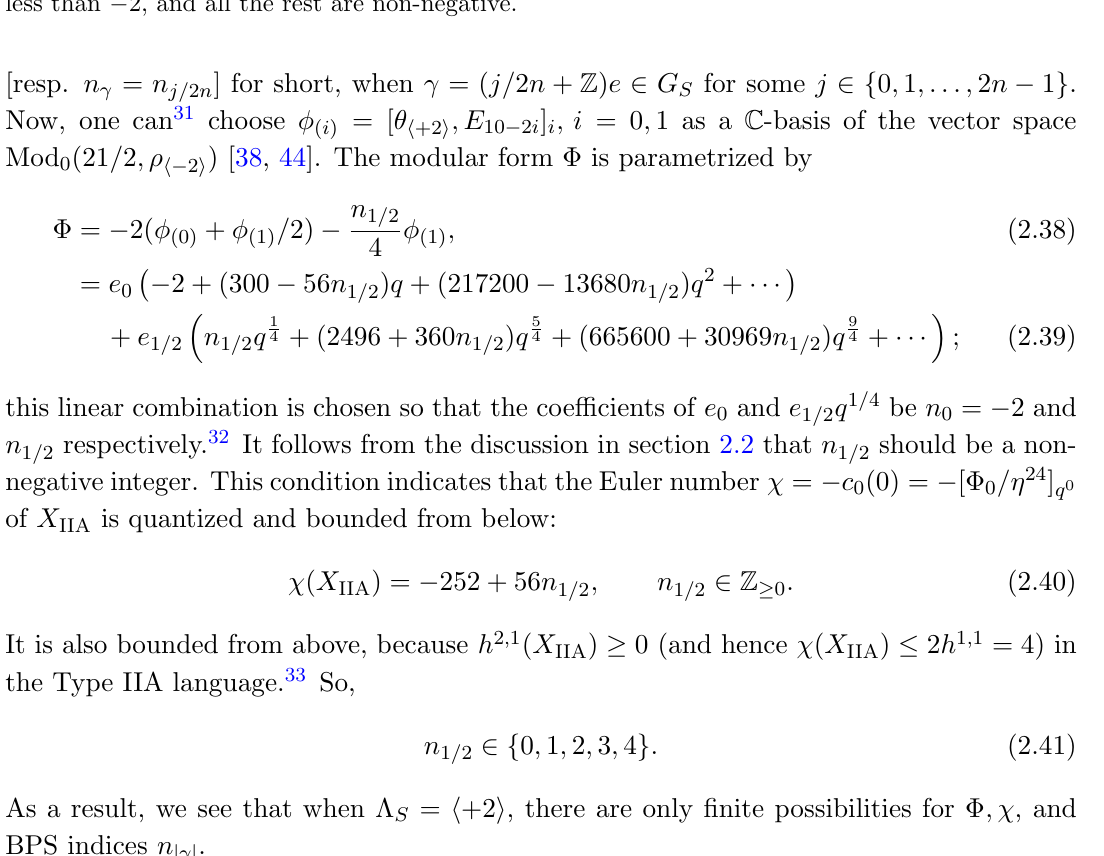
and n are not 2 = 4 3 = 6